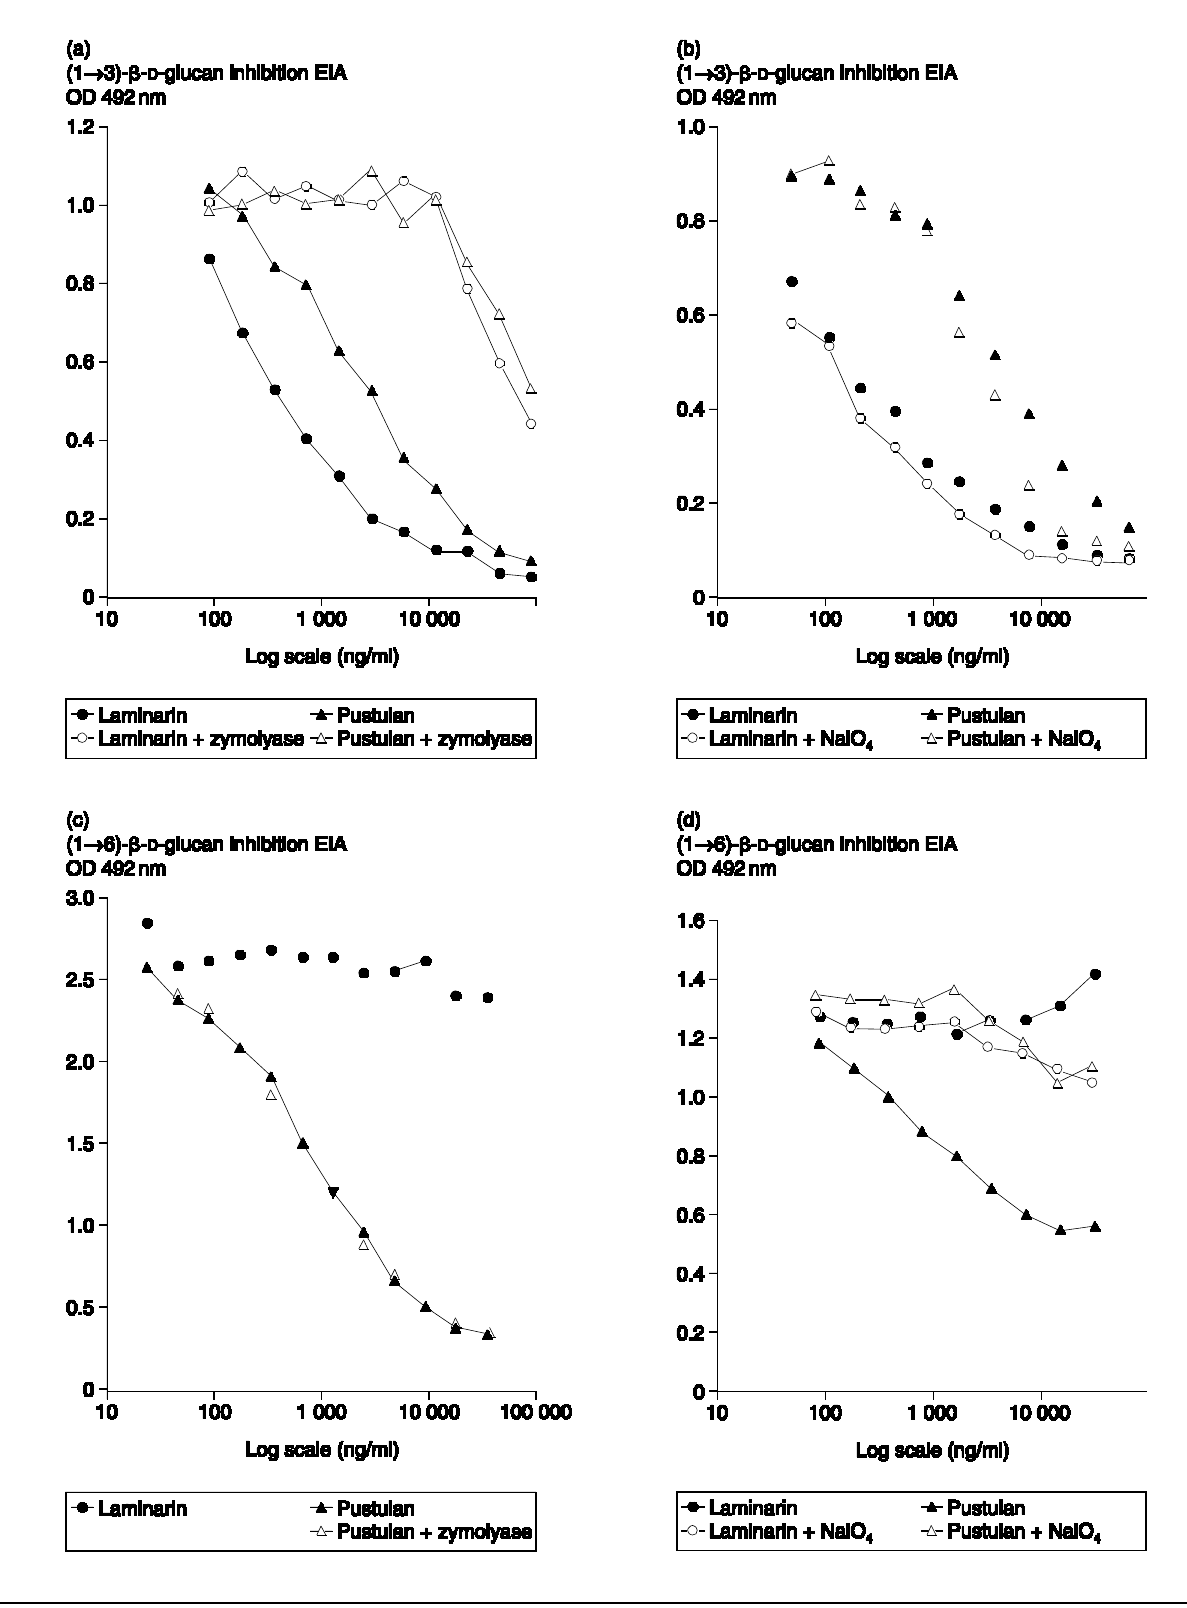
FIG. 2. Inhibition–dilution curves for untreated and zymolyase-treated laminarin and pustulan in (a) (1 ® 3)- b - D -glucan enzyme immu- noassay (EIA) and (c) (1 ® 6)- b - D -glucan EIA, and for untreated and NaIO and (d) (1 ® 6)- b - D -glucan EIA. OD, optical